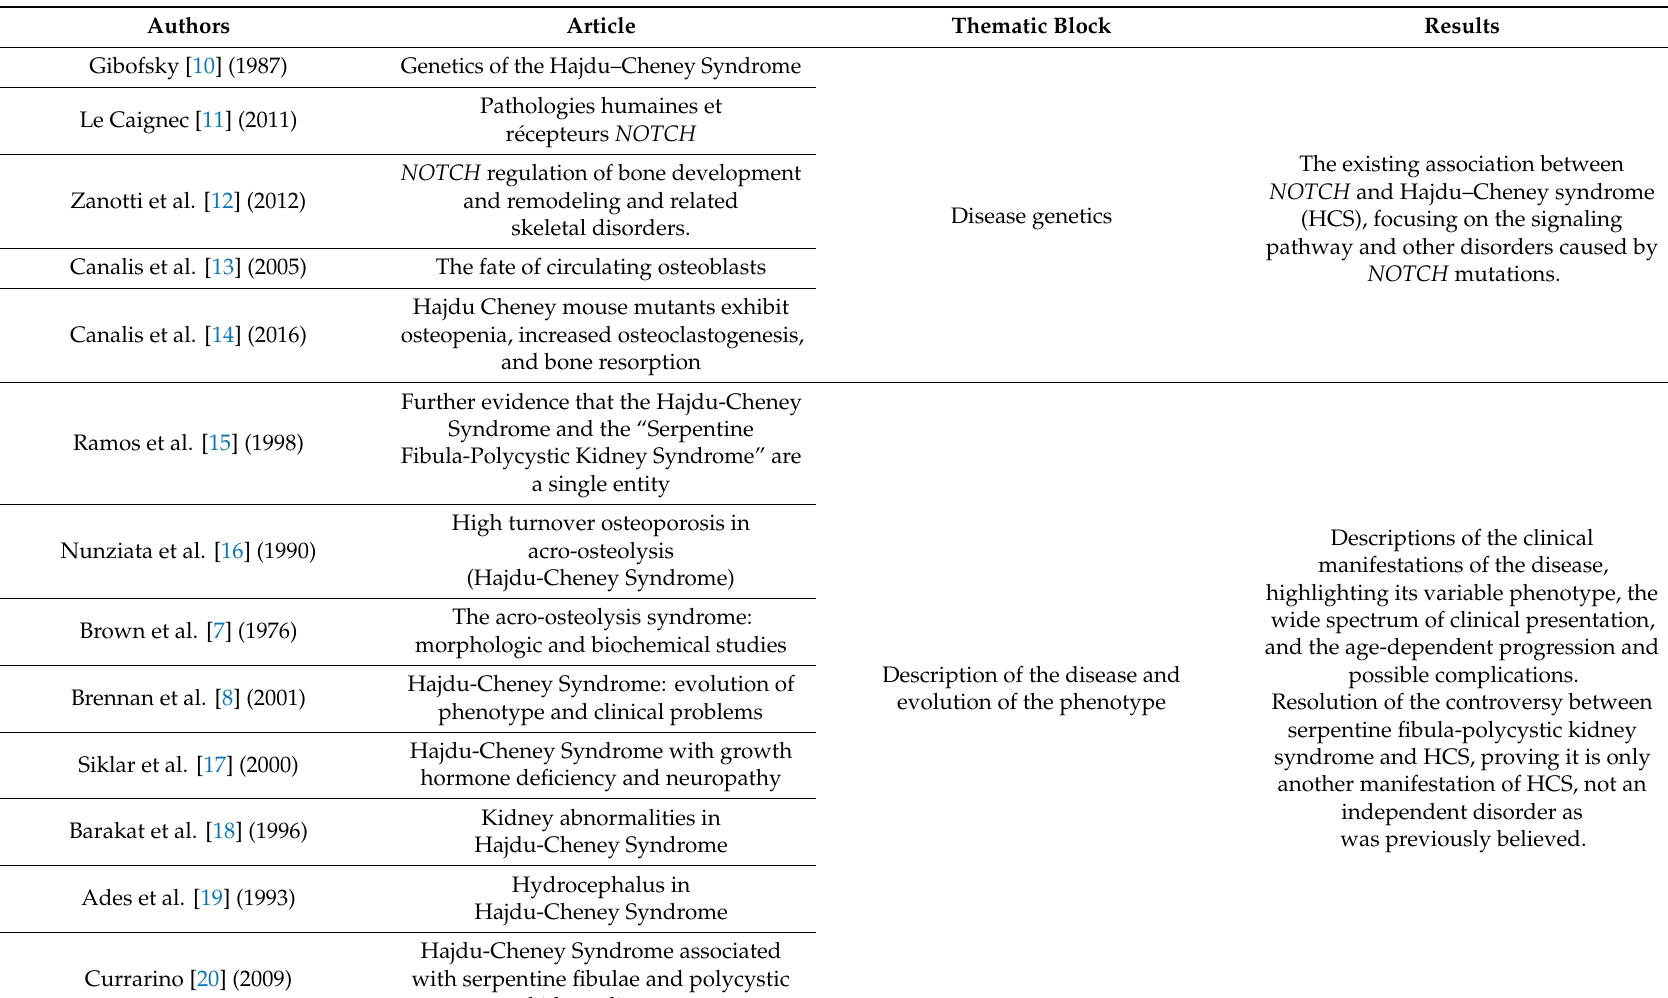
Table 2. Summary of the results of the most remarkable studies of this revision, divided by thematic